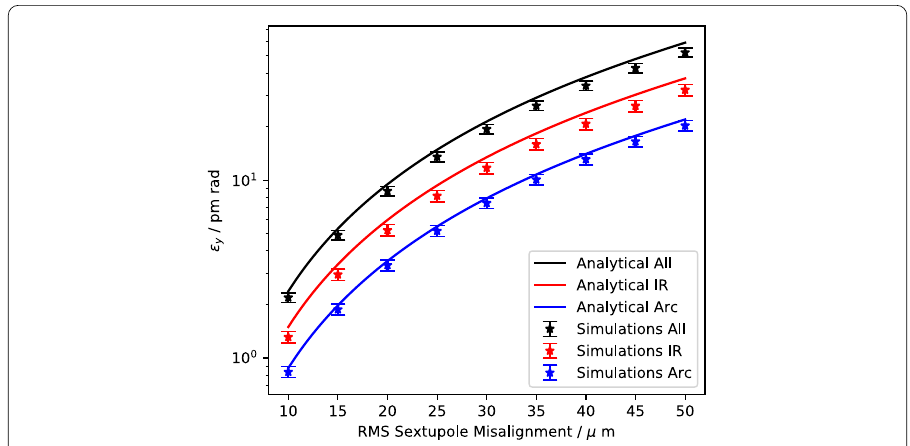
Figure 6 Vertical emittance due to sextupole vertical misalignment errors with increasing standard deviation, determined from analytical expression and average emittance from MAD-X simulations with 100 error seeds